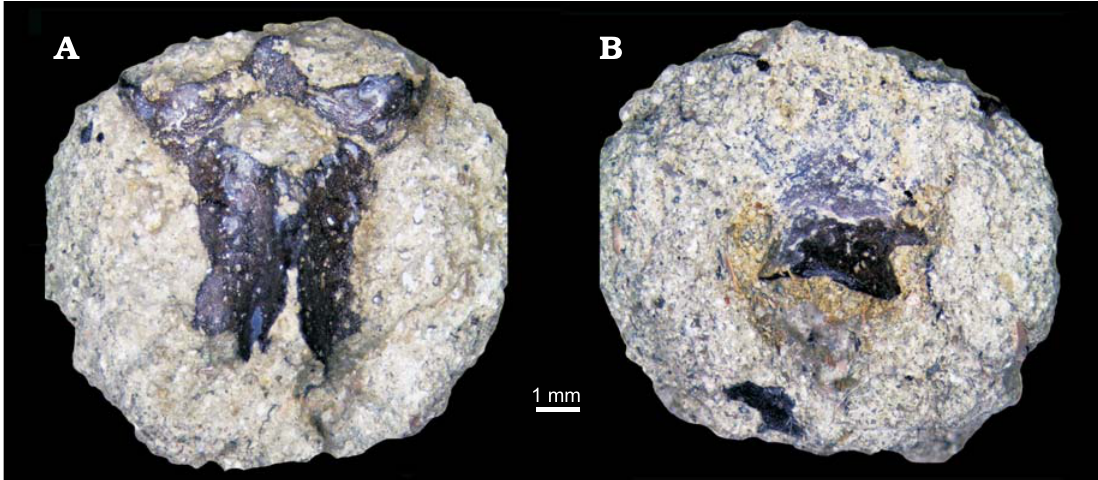
Fig. 2. Stem salamander Kulgeriherpeton ultimum gen. et sp. nov. from Teete locality, Yakutia, Eastern Siberia, Russia; Sangar Series, Batylykh Formation, Berriasian–Barremian, Lower Cretaceous. Atlas ZIN PH 3/246 (holotype) in dorsal ( A ) and ventral ( B ) views, with anterior end to top of figure.